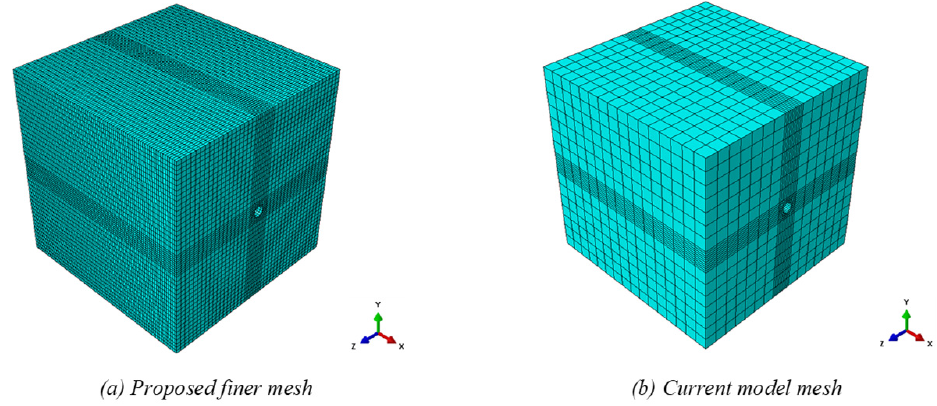
Figure 27. Comparison of proposed concrete box mesh with current mesh.